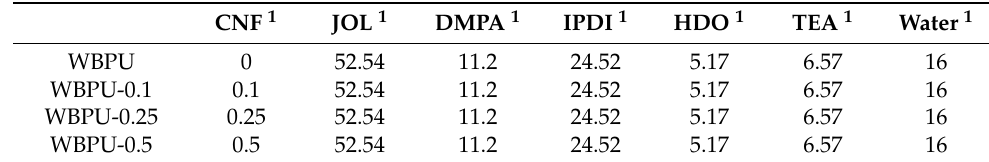
Table 1. Formulation of WBPU synthesis.